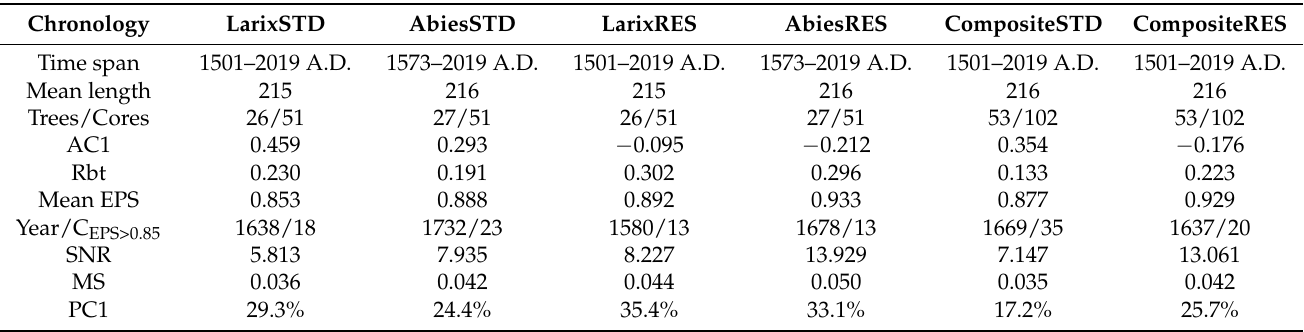
Table 2. Statistical parameters of MXD chronologies.